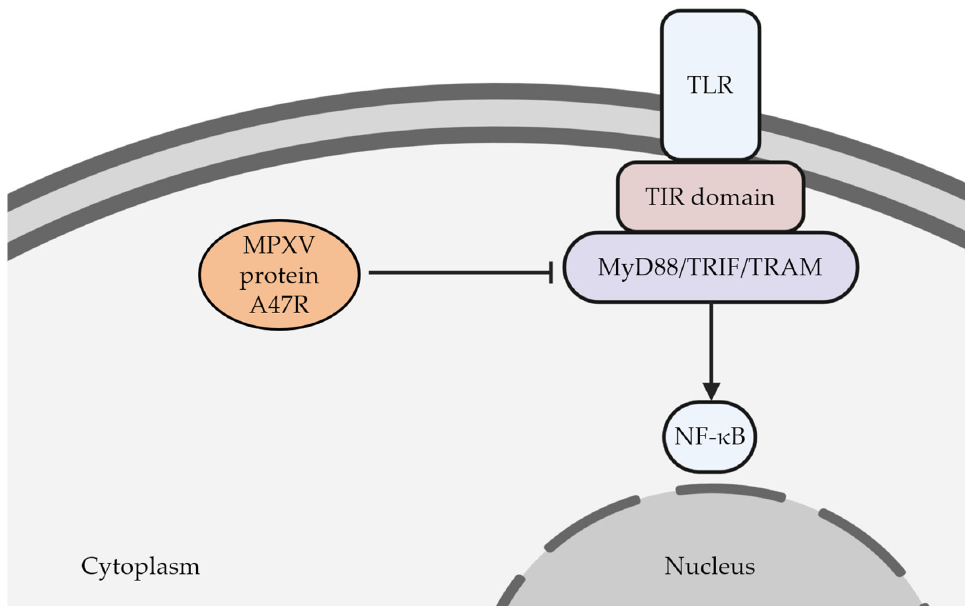
Figure 4. As a member of pattern recognition receptors (PRRs), TLR plays a critical role in recognizing various noxious molecules. Upon its interaction with those molecules, the cytoplasmic domain (TIR) of TLR recruits the appropriate adaptor proteins (e.g., MyD88, TRIF, or TRAM). This interaction induces the subsequent molecular pathways that will eventually upregulate the expression of NF- κ B, which is critical in modulating the innate immune system. It has been found that this mechanism can be impaired by the action of a MPXV protein called A47R. This viral protein can interact with the adaptor proteins leading to the impairment of viral recognition by the immune system. TLR (Toll-like receptor); TIR (Toll/interleukin-1 receptor); MyD88 (myeloid differentiation primary-response gene 88); TRIF (TIR-domain-containing adaptor protein inducing IFN β ); TRAM (TRIF-related adaptor molecule); NF- κ B (nuclear factor kappa B). The figure was created by